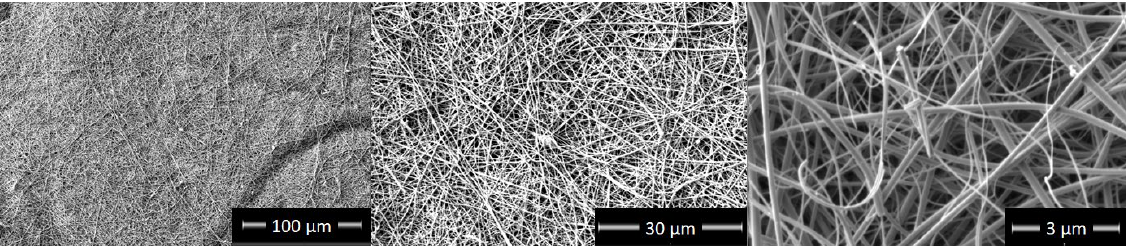
Figure 1. Scanning electron microscopy (SEM) images of Titanium oxynitride carbon composite nanofibers (2nd sample, TiON/C-CNF2) fabric at different magnifications.